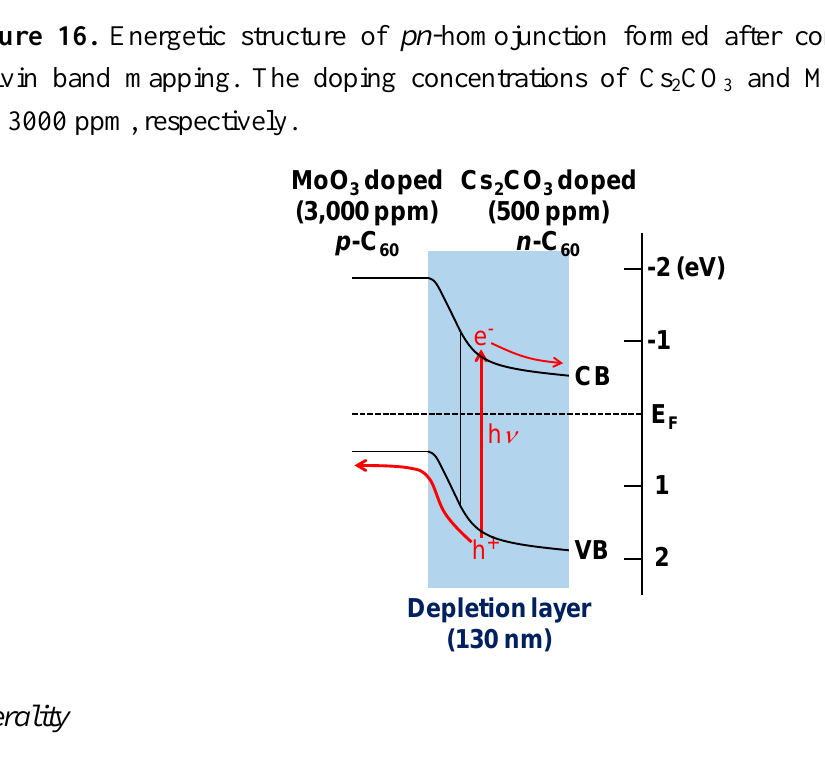
CO and MoO are 500 ppm 2 3 3